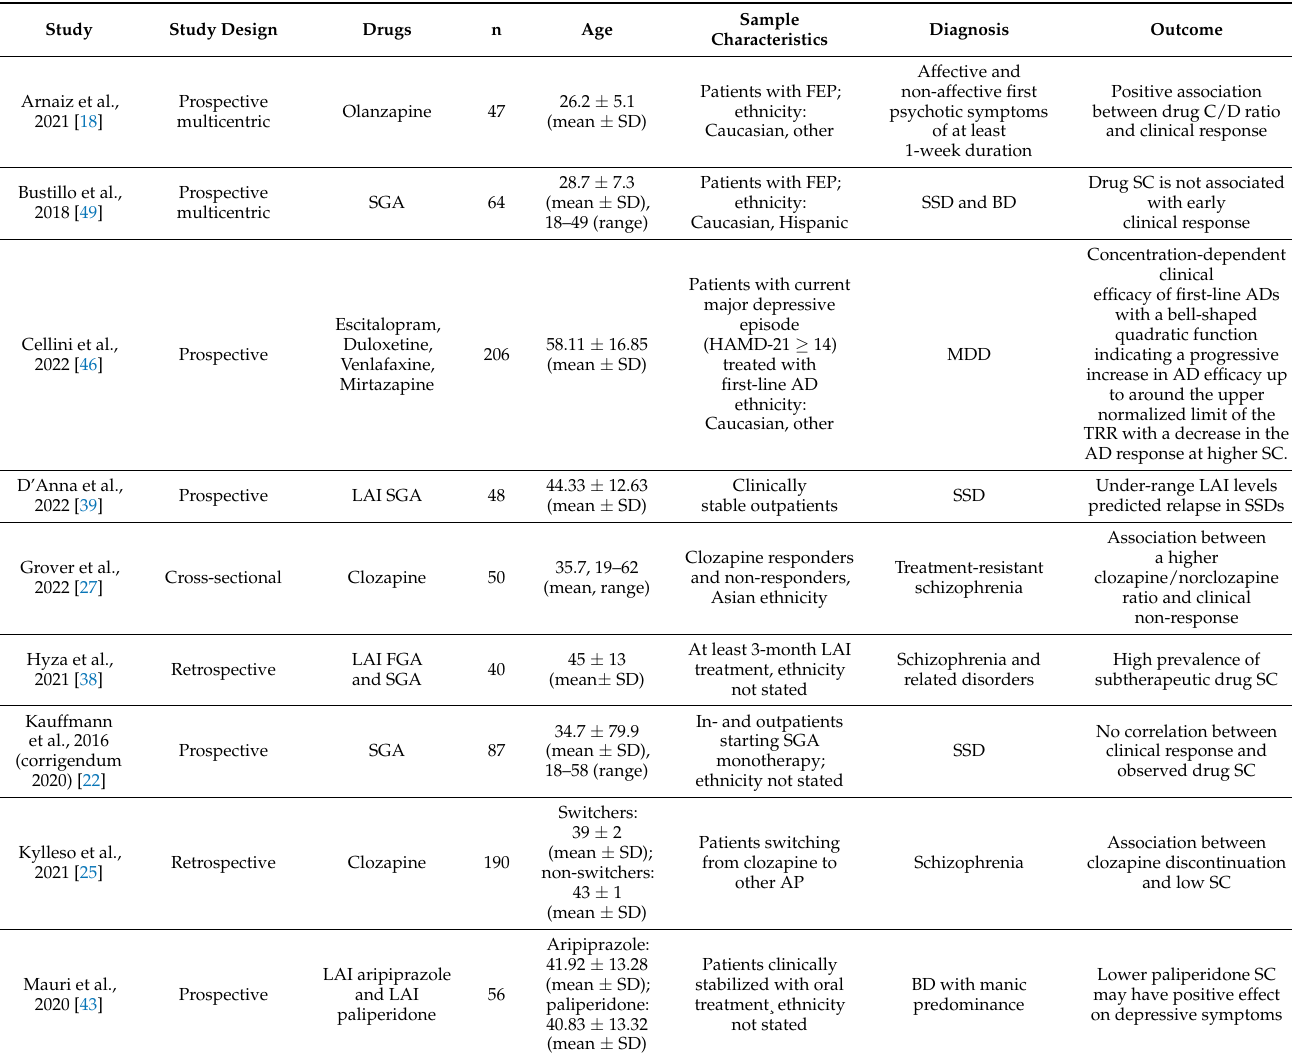
Table 2. Original articles on the use of TDM to ensure treatment